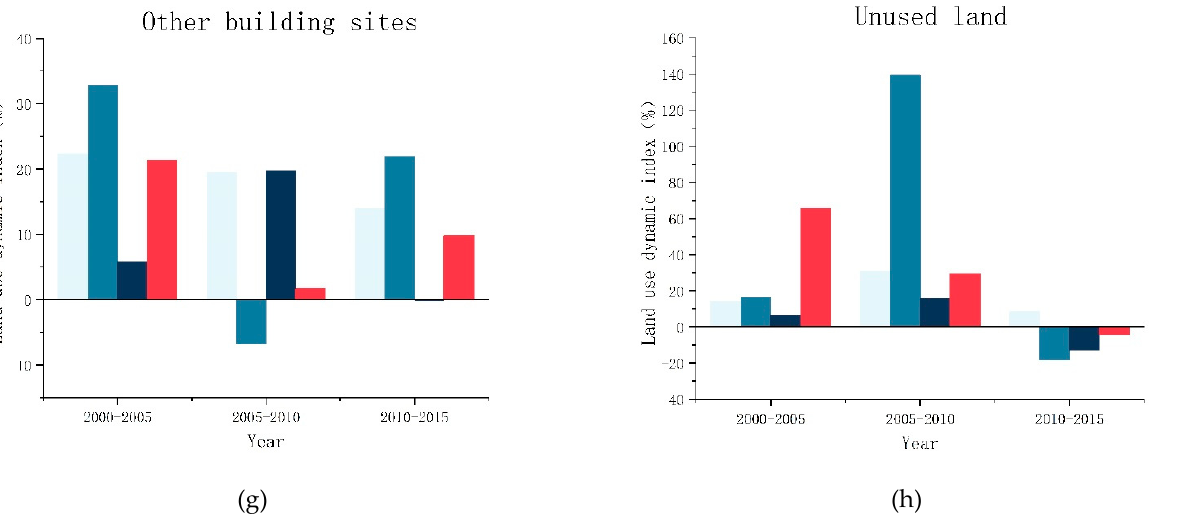
Figure 5. Changes in the dynamic land use attitude gradient in the buffer zones of Dalian. (a) Agricultural land, (b) Woodland, (c) Grassland, (d) Water bodies, (e) Urban building sites, (f) Rural building land, (g) Other building sites, (h) Unused land.